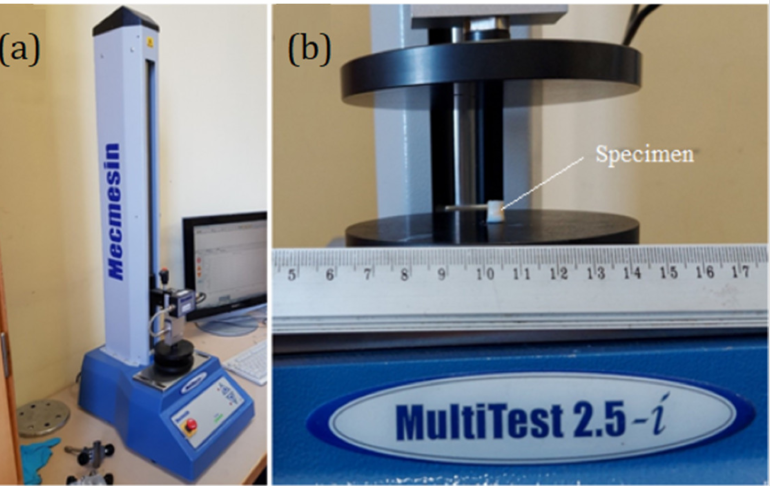
Figure 2. ( a ): Single-column force tester, MultiTest 2.5-i; ( b ): Cylindrical specimen extracted from the human meniscus.